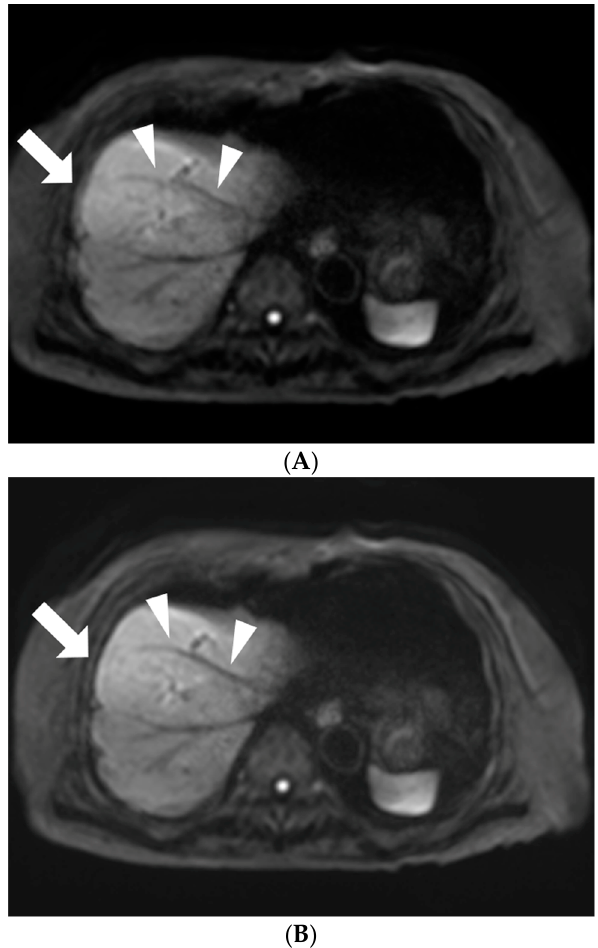
Figure 3. An 81-year-old woman with gallbladder cancer who underwent DWI. ( A ) Axial c-DWI (b = 800 s/mm 2 ) and ( B ) axial moco-DWI (b = 800 s/mm 2 ). The delineation of the intrahepatic vessel (arrowheads) as well as liver margin sharpness (arrows) are superior in moco-DWI ( B ) to those in c-DWI ( A ).